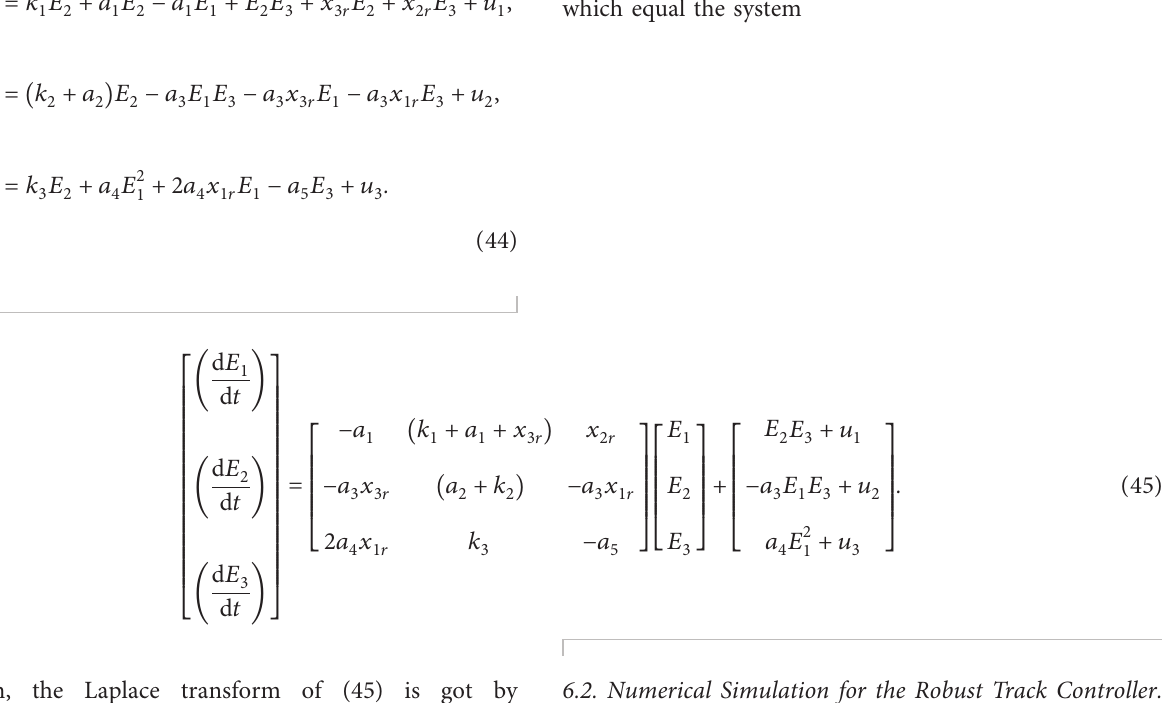
system response before and after control with the corre- sponding track errors. The controller drives the states to follow the reference values: x